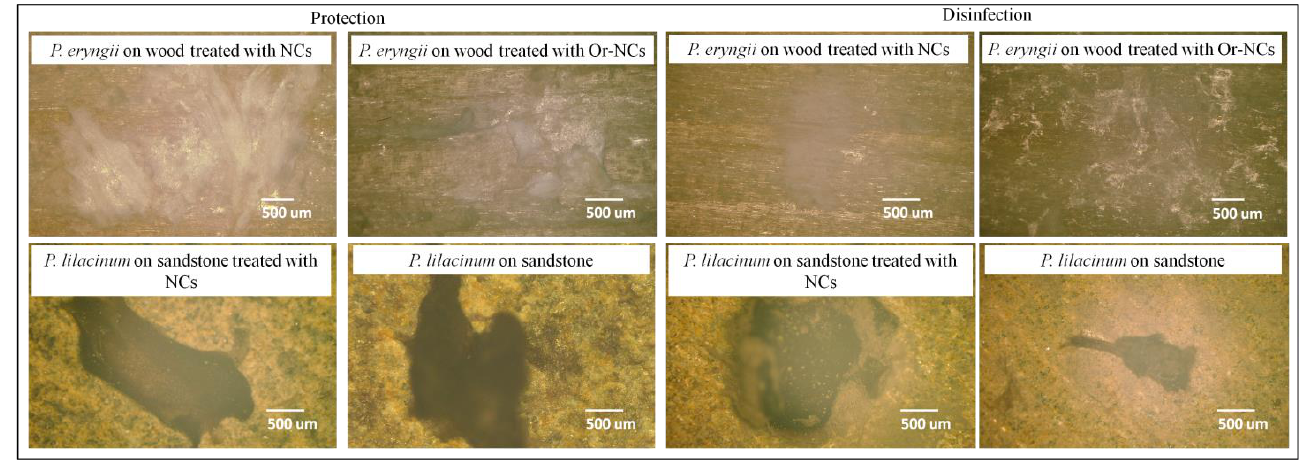
Figure 5. P. eryngii and P. lilacinum on wood and sandstone observed by digital microscopy.